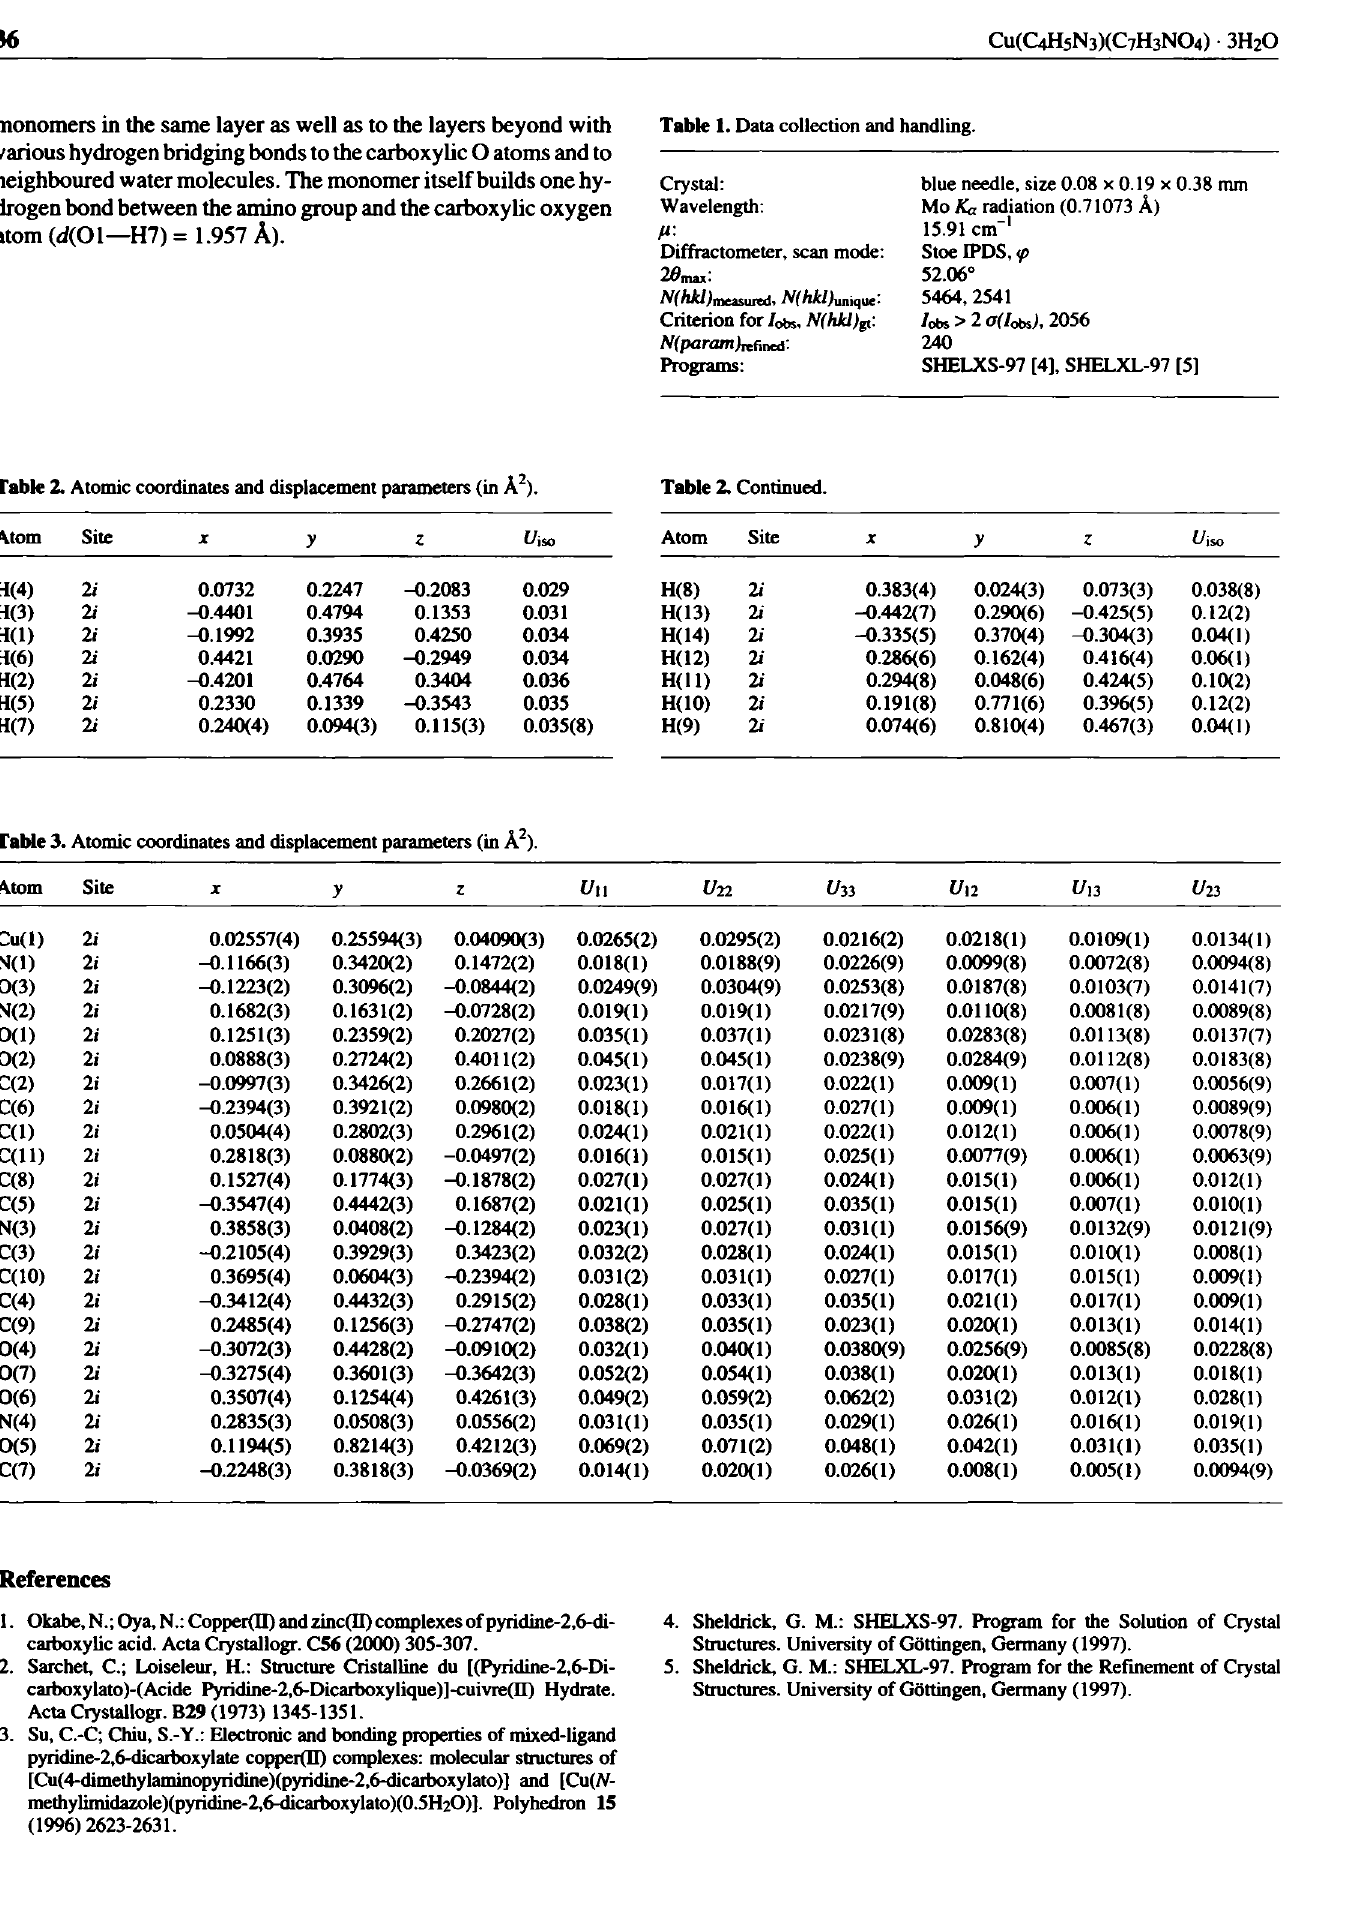
Table 2. Atomic coordinates and displacement parameters (in Â 2 ).